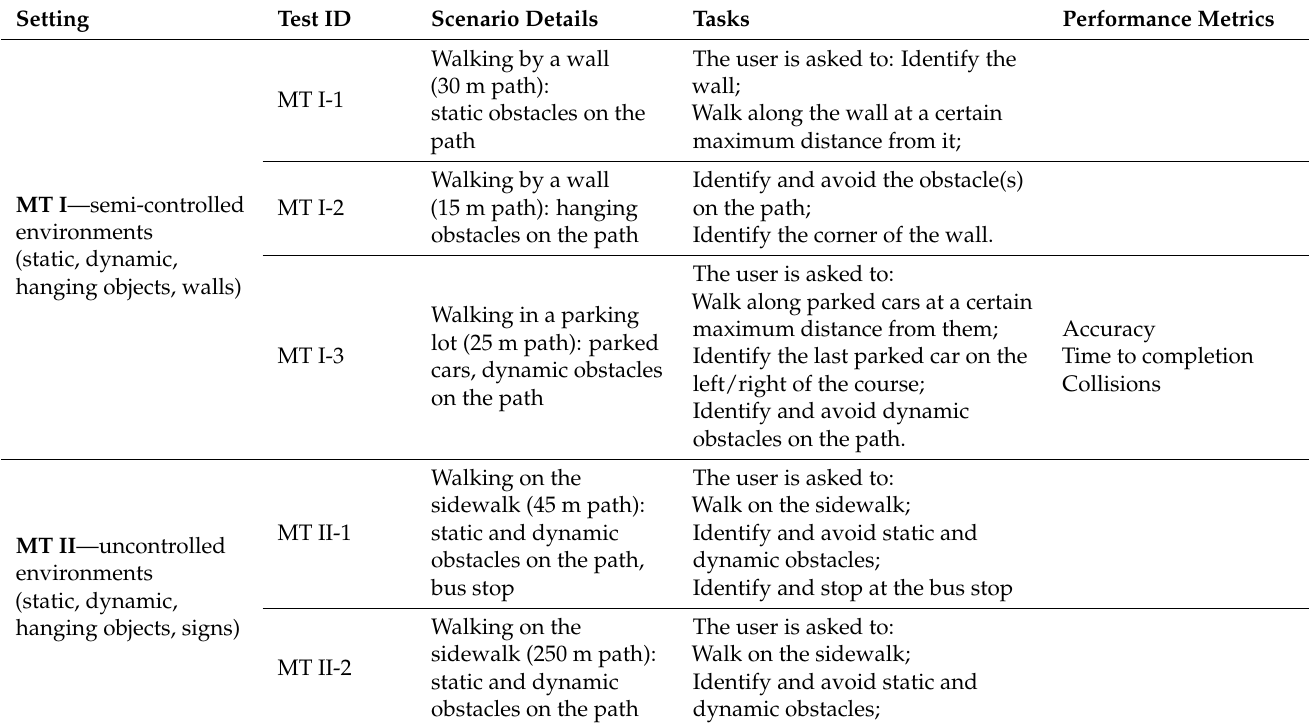
Table 3. Overview of the tests designed for evaluation of mobility in outdoor environments with the SoV device (MT—mobility